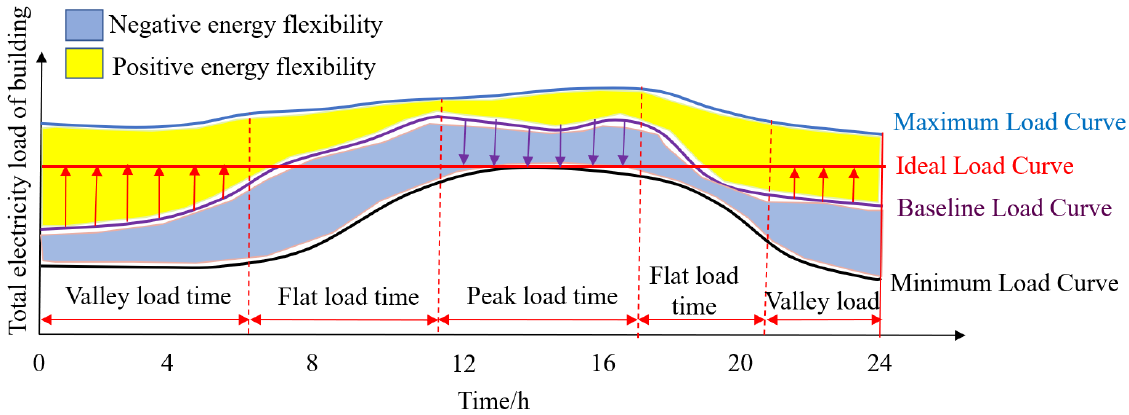
Figure 3. Schematic diagram of energy flexibility in buildings.